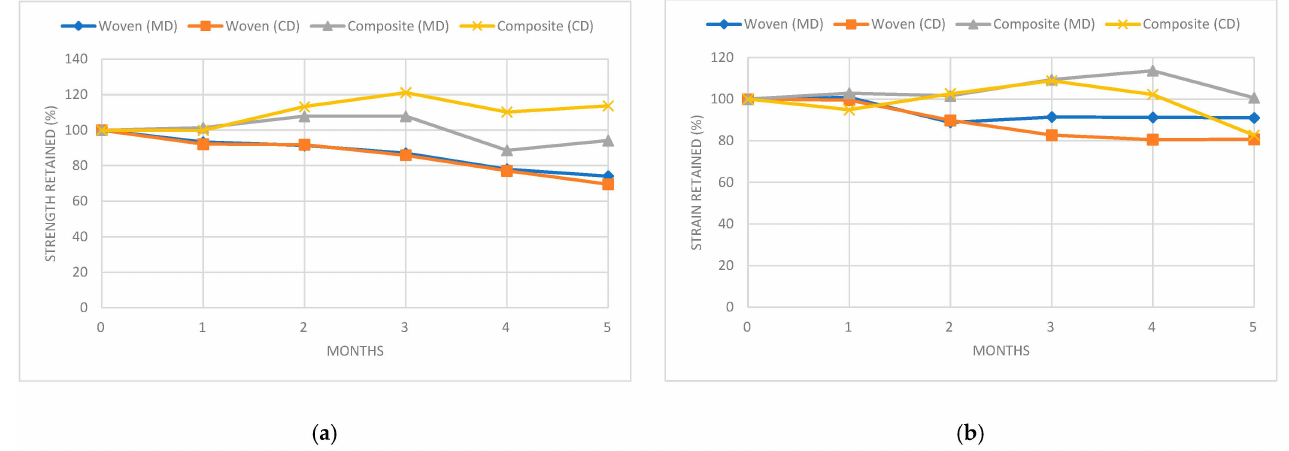
Figure 5. ( a ) Tensile retained strength percentage of woven and composite geotextiles in both machine (MD) and cross-machine directions (CD); ( b ) retained strain percentage of woven and composite geotextiles in both machine (MD) and cross-machine directions